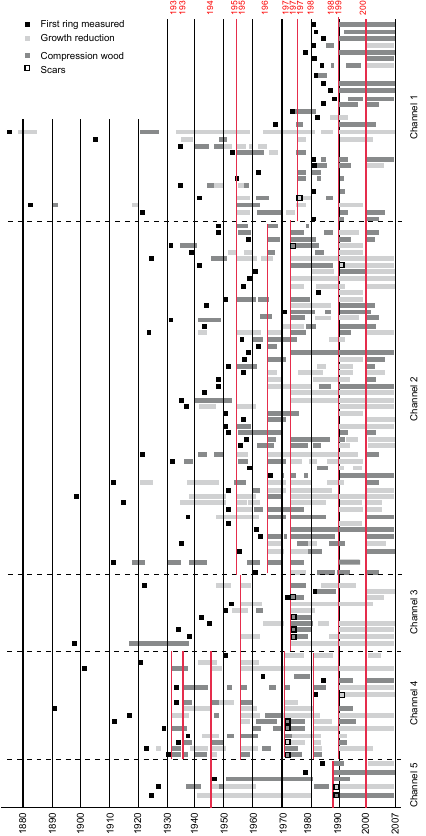
Fig. 6. Skeleton plot showing event responses from tree sam- ples collected in or next to the five abandoned channels of the Manival